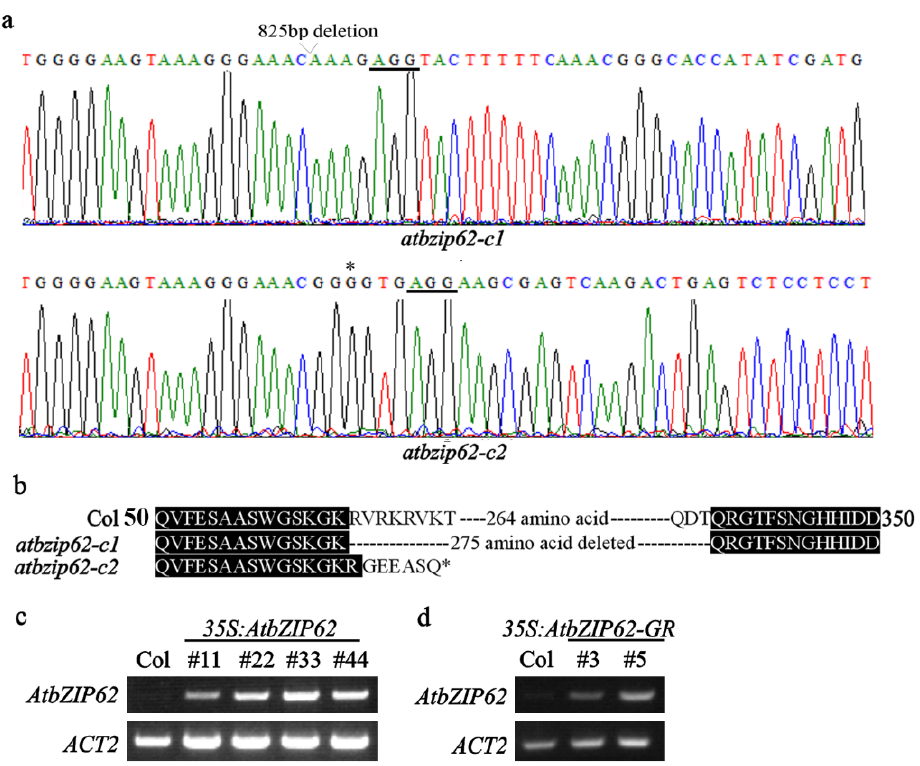
Figure 3. Generation of the transgenic overexpression lines and gene-edited mutants of AtbZIP62. ( a ) Editing status of AtbZIP62 in the atbzip62 mutants. DNA was isolated from leaves of T2 plants with normal flowering and used for RT-PCR amplification of AtbZIP62 and sequencing. The underlines indicate the PAM sites, the open arrow end indicates the site where fragment deletion occurred,